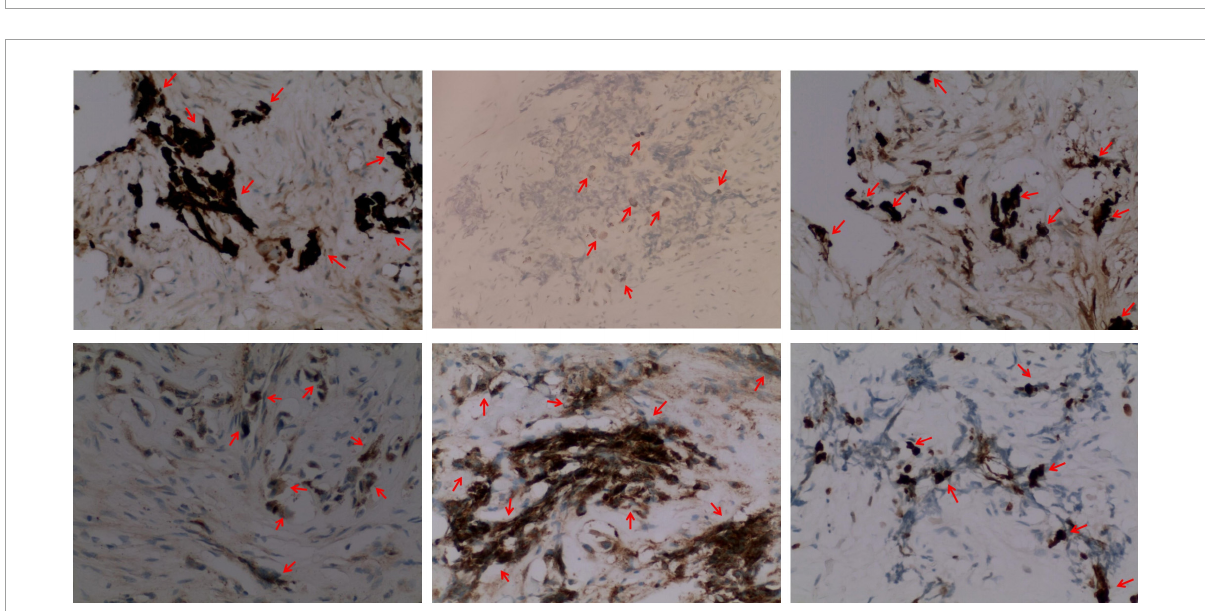
FIGURE4 Representative immunohistochemical staining images ( × 200) (from left to right) of the MNT1 tumor sections for cytokeratin (CK, epithelioid +), S-100 protein (epithelioid +), melanoma antibody (HMB45, epithelioid +), neuron-specific dilute alcoholase (NSE, small round cell +), synaptophysin (Syn, small round cell +), and Ki67. Nearly, 15% of the nuclei were Ki-67